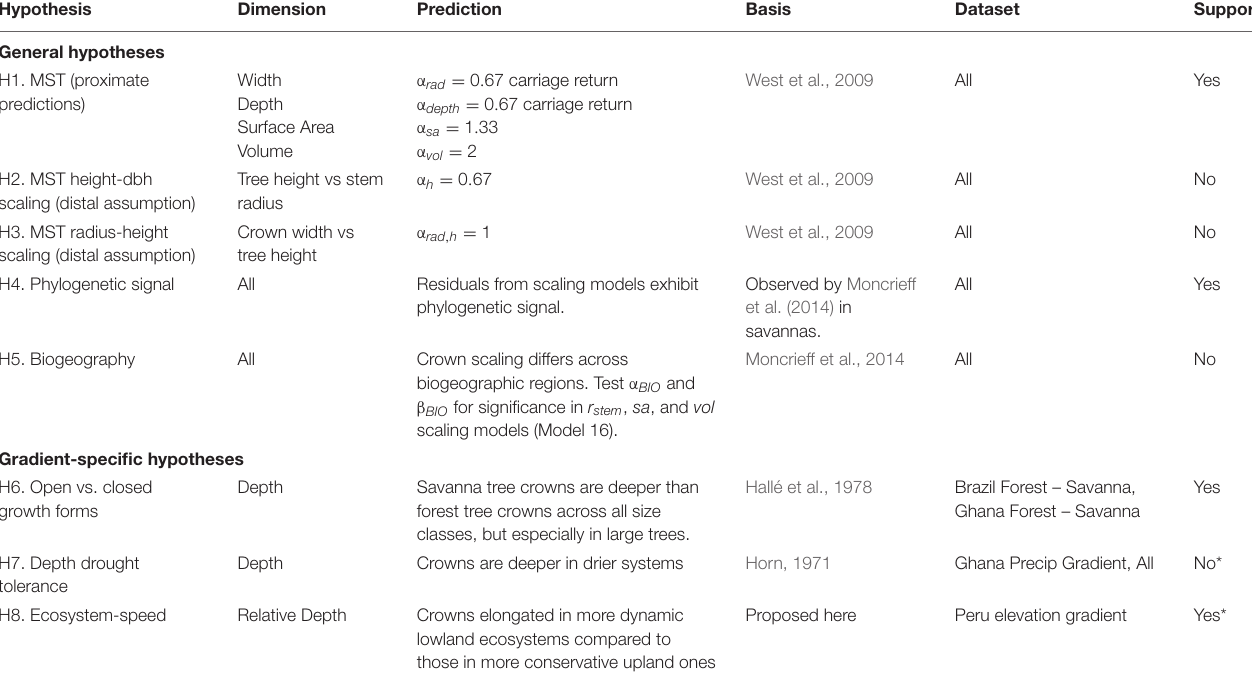
TABLE 1 | Hypotheses tested in this